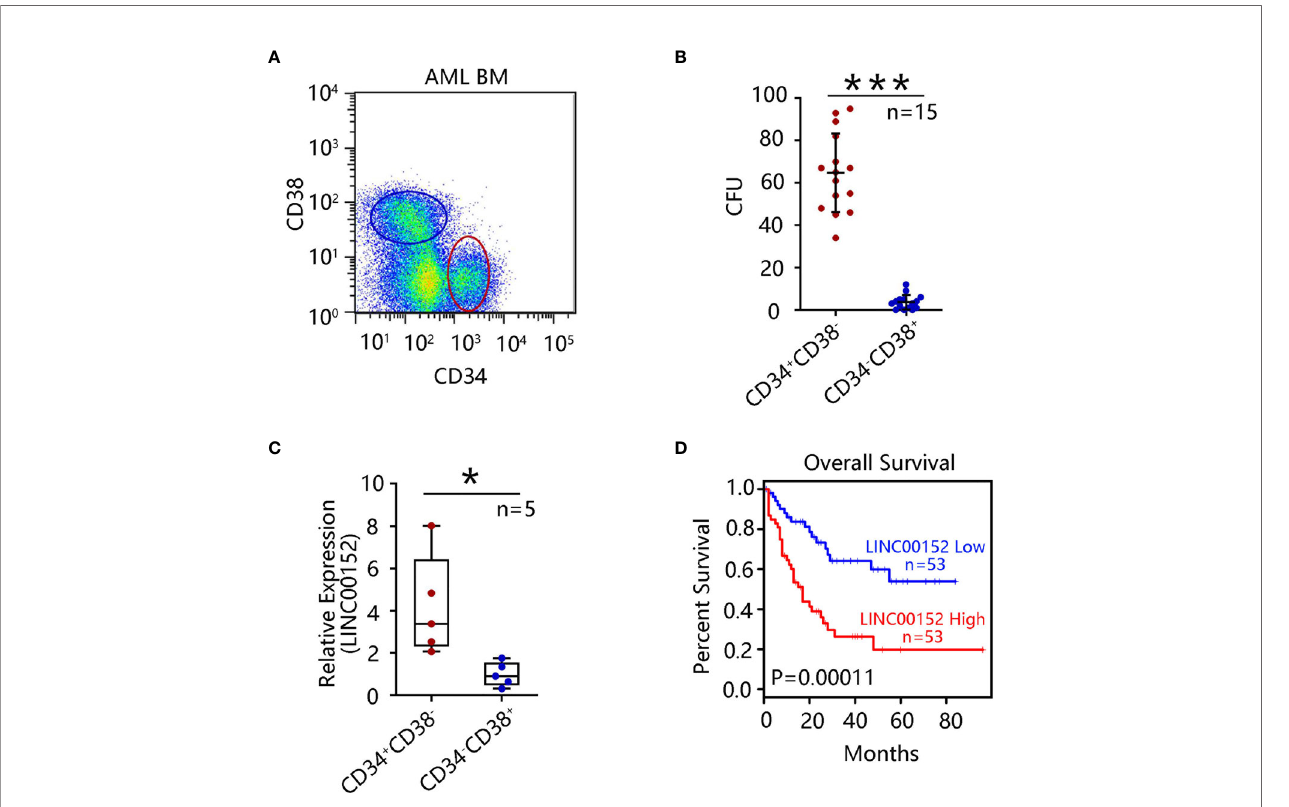
FIGURE 1 | LINC00152 expression is upregulated in leukemia stem cells (LSCs). (A) CD34 + CD38 − and CD34 − CD38 + cell subpopulations were sorted by fl ow cytometry from 15 acute myeloid leukemia (AML) patients. (B) Colony formation assay using sorted CD34 + CD38 − and CD34 − CD38 + cells was performed and the mean number of clone forming units was analyzed. Data are presented as the mean ± SEM of three independent experiments (*** P < 0.001). (C) LINC00152 expression in CD34 + CD38 − and CD34 − CD38 + cells derived from fi ve AML patients. Data are represented as the mean ± SD of three independent experiments (* P < 0.05). (D) Correlation between overall survival of AML patients and LINC00152 expression (based on a publicly available data set by gene expression pro fi ling interactive analysis (*** P <